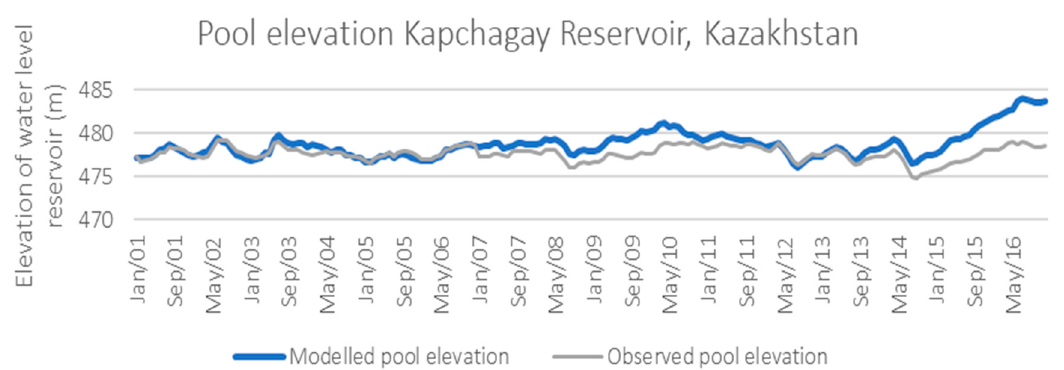
Figure A6. Pool elevation model predictions for Kapchagay Figure A6 Pool elevation model predictions for Kapchagay reservoir.